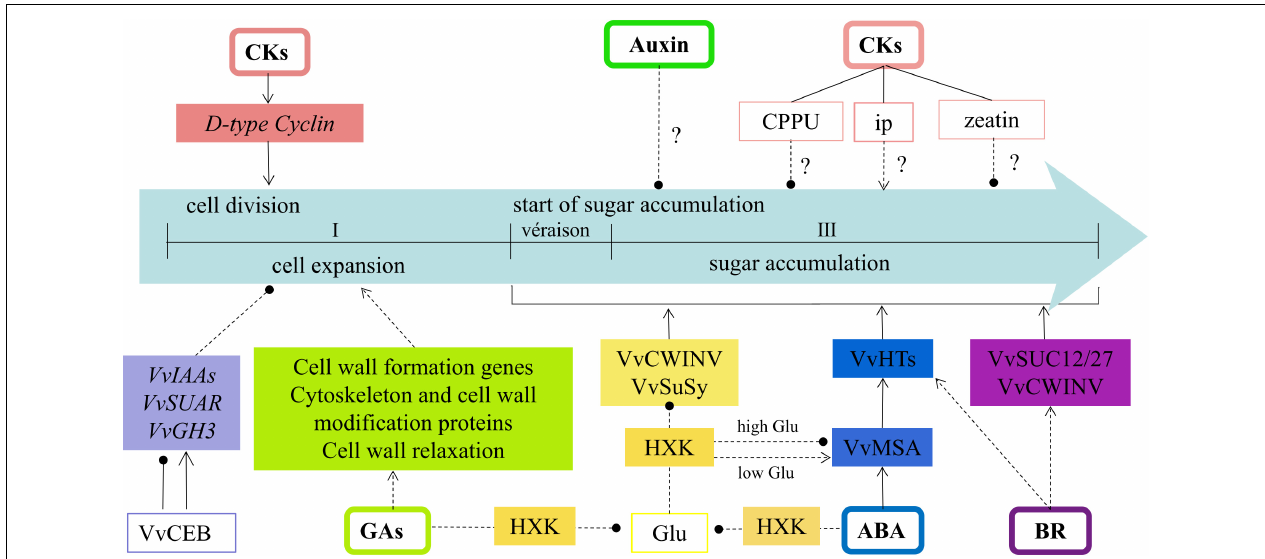
FIGURE 2 | The regulation model of hormones on sink strength reported in grape. Symbol ‘?’ means no clear relationship between hormones and sink activity (sugar accumulation), → stands for promotion, — • stands for inhibition. Solid line means direct regulation relationship, dotted line means indirect regulation relationship or no further study for direct